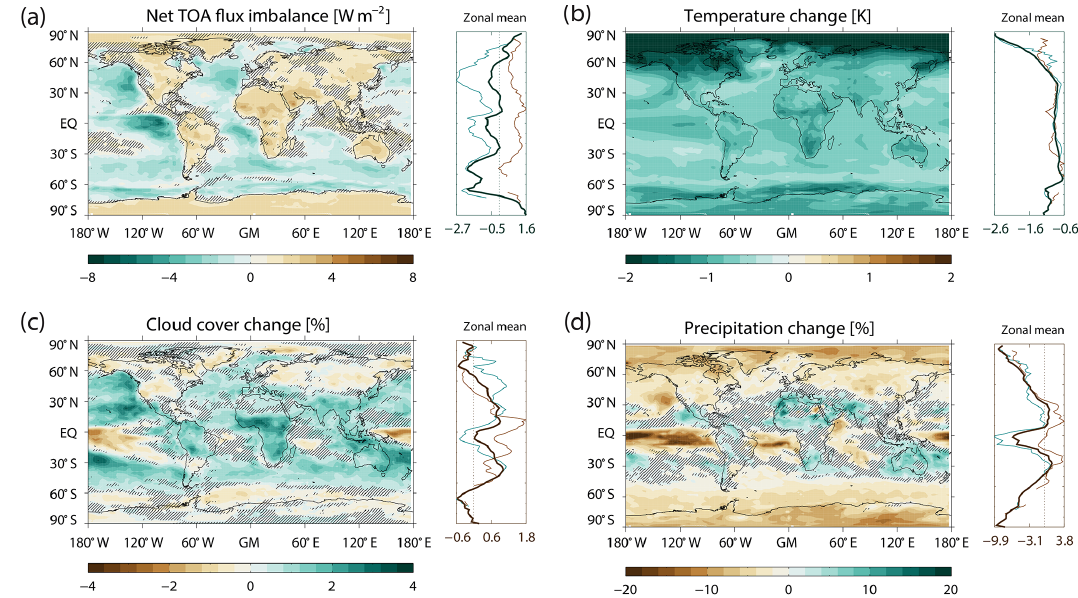
Figure 4. Ensemble median (taken in each grid cell) G4cdnc-RCP4.5 difference based on years 2020–2069 of (a) TOA net radiative flux imbalance (Wm − 2 ) , (b) near-surface air temperature change (K), (c) total cloud cover (%), and (d) precipitation (%). Hatched areas are grid cells where fewer than 75% of the models agreed on the sign of the change. Zonal averages are given to the right of each panel, where brown and blue lines indicate land-only and ocean-only averages. See Figs. S2 and S3 in the Supplement for individual model changes in cloud cover and precipitation,